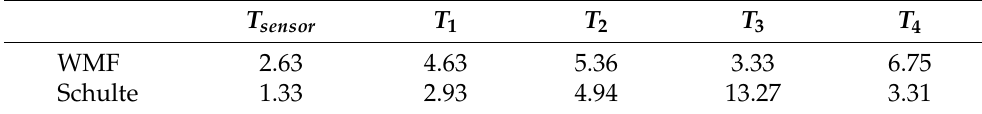
Table 4. MAE of the three models with Model I. T sensor , T 1 , T 2 , T 3 and T 4 are the thermocouples in Figure 1b. The units are ◦ C.